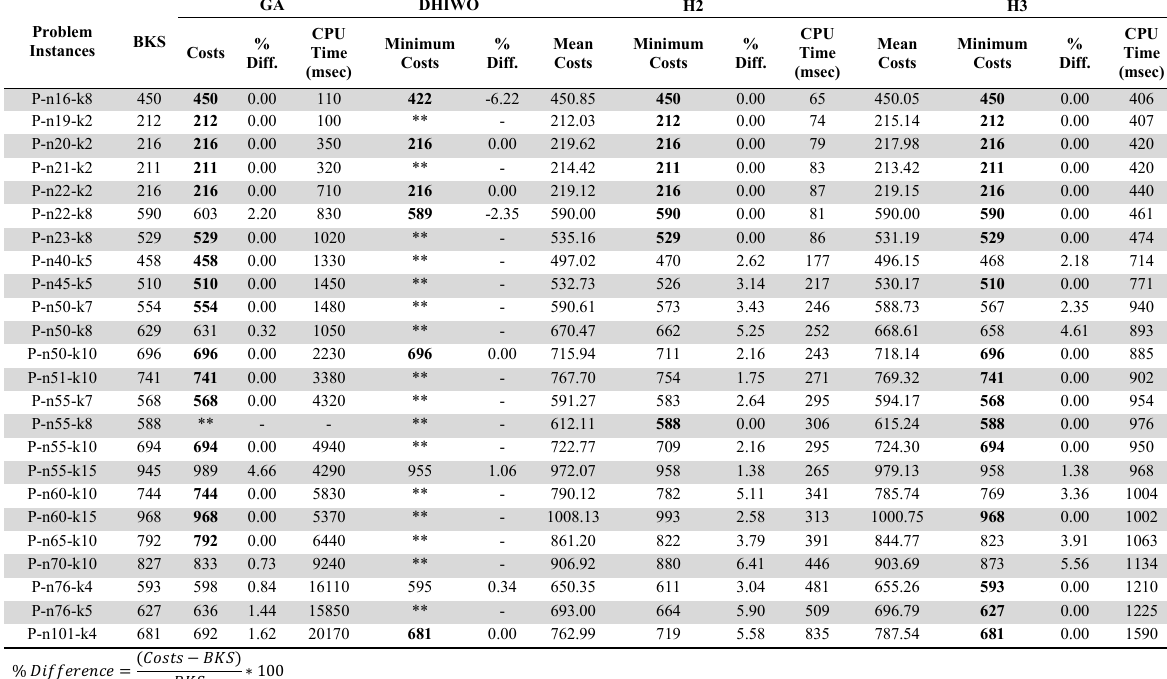
Table 3 Comparison of the results with previous works Problem